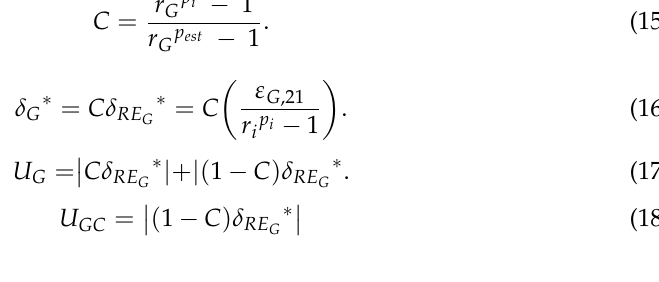
Table 3. Results of grid convergence